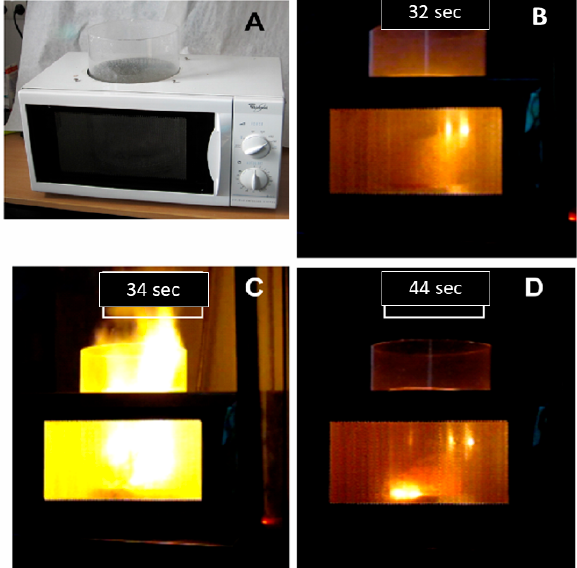
Figure 8. Microwave-assisted combustion synthesis setup using DMO equipment ( A ). Synthesis progression at 32 ( B ), 34 ( C ), and 44 s ( D ). Such extensive modification in DMOs needs thorough consideration of the involved hazards, mainly microwave leakage. Reproduced from ref. [85,90] with permission from The Royal Society of Chemistry.